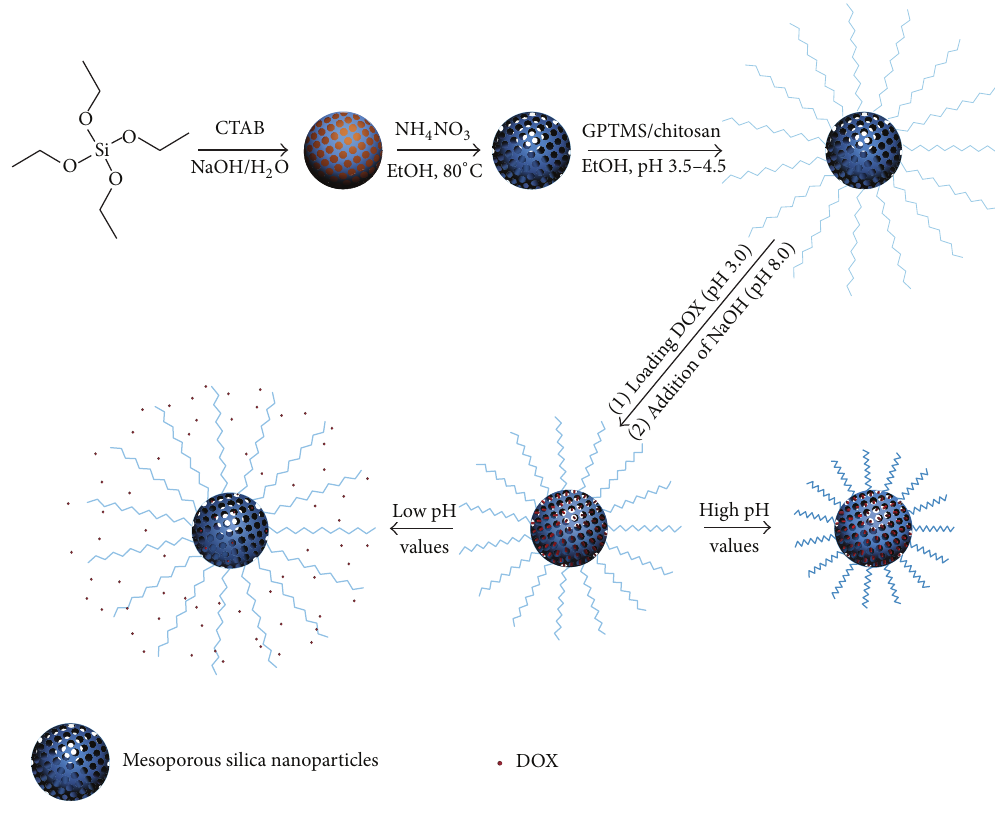
Figure 1: Schematic representation of the formation of chitosan-capped MSNPs and the loading and release of the drug doxorubicin hydrochloride (DOX) by changing the pH value (reproduced from [46], with permission from Wiley-VCH Verlag GmbH & Co.